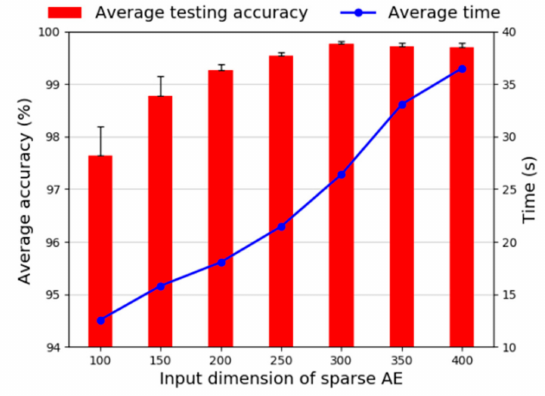
Figure 12. Diagnosis accuracy of various input dimension.